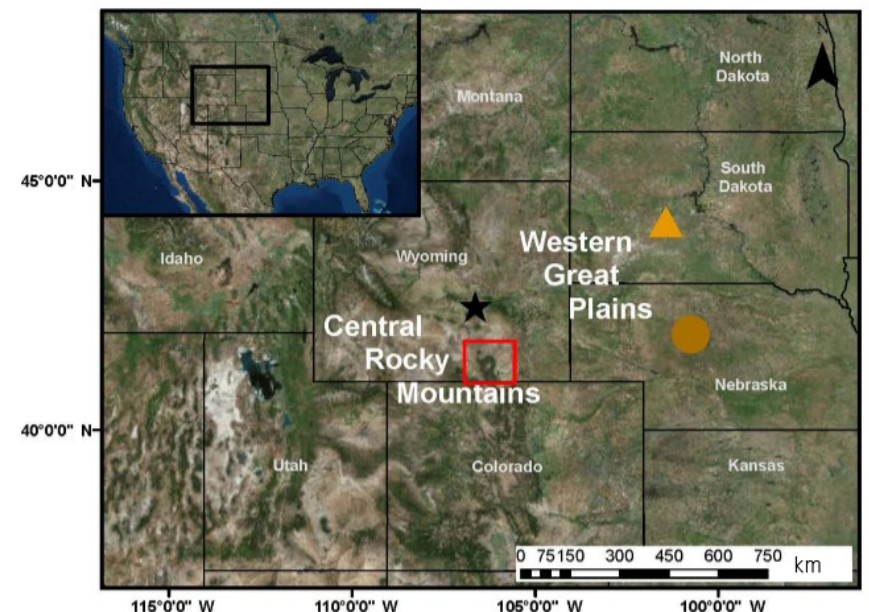
Figure 2. Location map of the study region in the western United States (inset panel; black box). Sedimentary proxy data analysed in this study come from Long Lake, Wyoming (red box) located in southeastern Wyoming within the central Rocky Mountain region on the edge of the western Great Plains. Long Lake experienced a unique change in vegetation composition ∼ 4000calyrBP in response to persistent drought conditions ∼ 4200calyrBP. Regionally, several dune fields reactivated in response to regional droughts ∼ 4000calyrBP; the black star depicts the region where the Ferris dunes (Stokes and Gaylord, 1993) and Casper dunes (Halfen et al., 2010) are located. The orange triangle depicts the White River Badlands dunes (Rawling et al., 2003) of South Dakota. Lastly, the brown circle indicates the Nebraska Hills dune field (Schmieder et al., 2011; Miao et al., 2007; Mason et al., 2004; Goble et al., 2004; Stokes and Swinehart, 1997; Loope et al., 1995; Ahlbrandt et al., 1983; Madole,